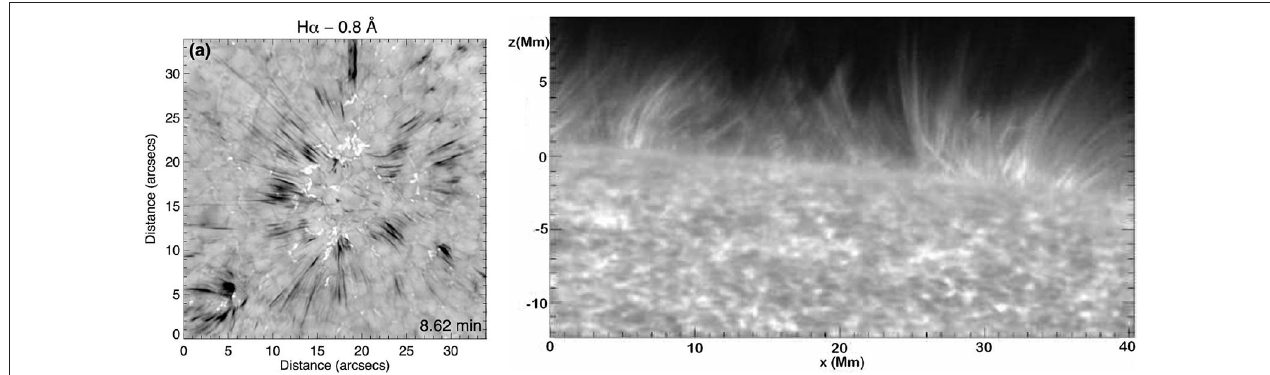
FIGURE 10 | High resolution images of H α spicules near the center of the disk from the Goode Solar Telescope, Big Bear (left, from Sterling et al., 2020, © AAS, reproduced with permission, based on work by Samanta et al., 2019) and at the limb observed in the Ca II H line with the Solar Optical Telescope (SOT) aboard Hinode (right, from Judge and Carlsson, 2010, © AAS, reproduced with permission).